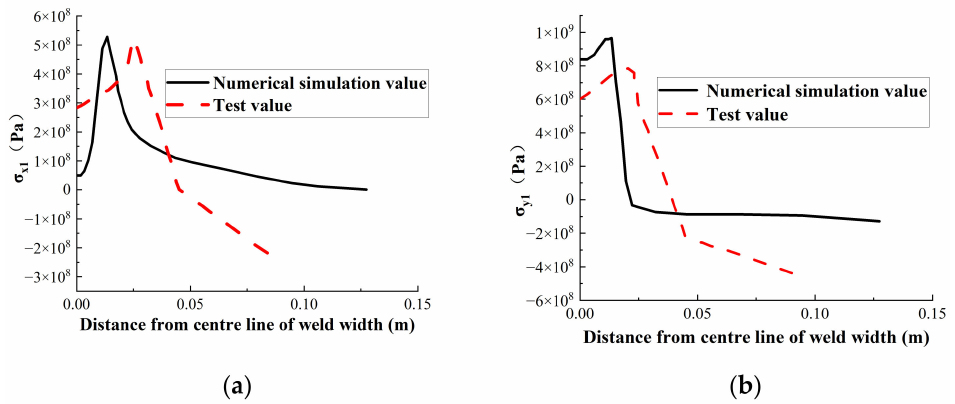
Figure 8. Numerical simulation results of residual stress along Path 1 and test results from [35] for ( a ) transverse residual stress σ x 1 ; ( b ) longitudinal residual stress σ y 1